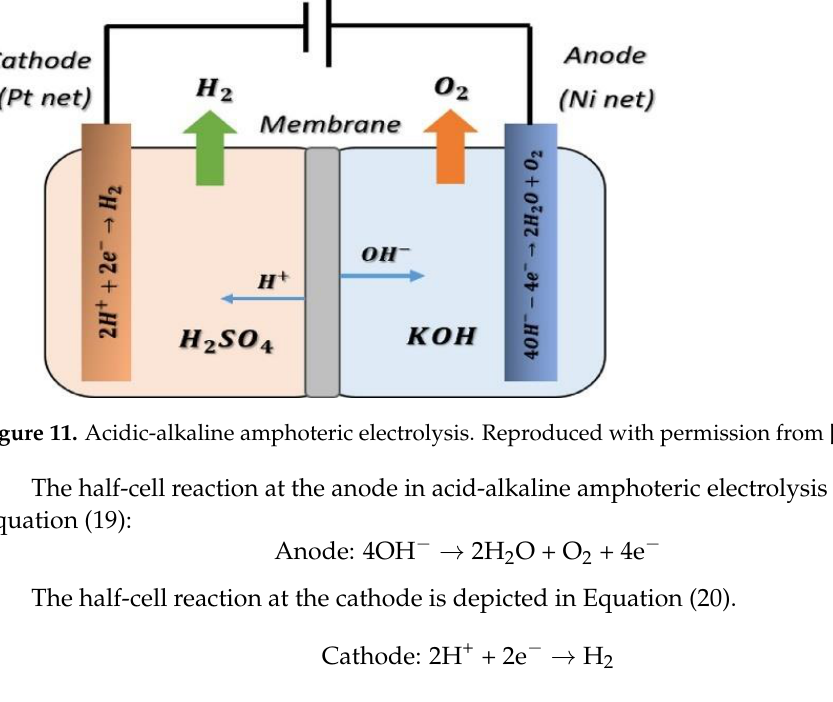
Table 5. Summary of acid-alkaline amphoteric electrolysis for hydrogen production.